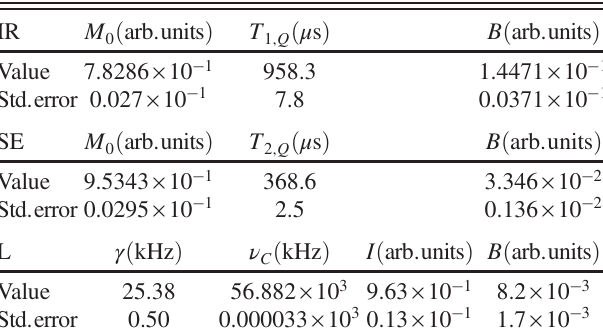
TABLE IV. Example for fitting result of Fig. 9, including result and standard error according to Eqs. (B1), (B2), and (B3).